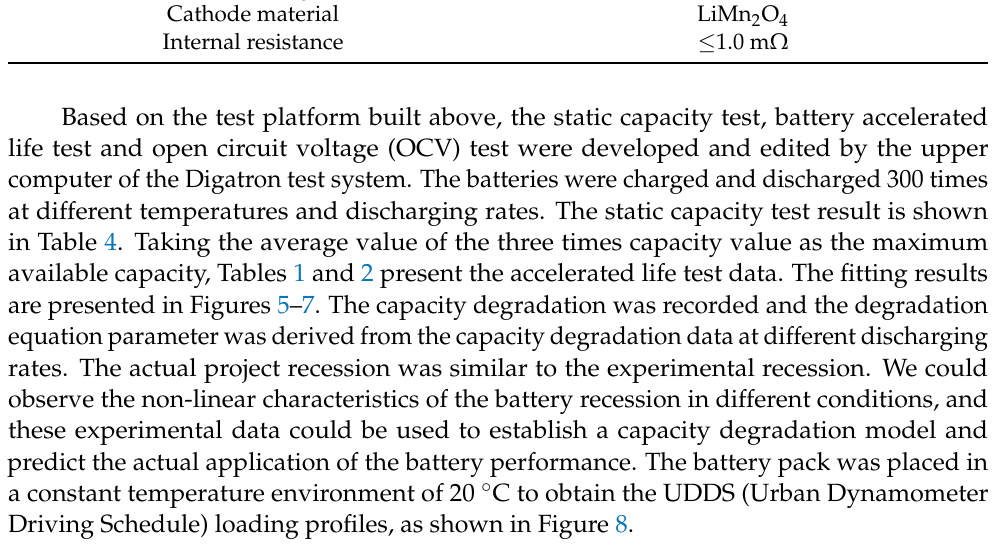
Figure 5. Capacity degradation curves at different discharge rates.